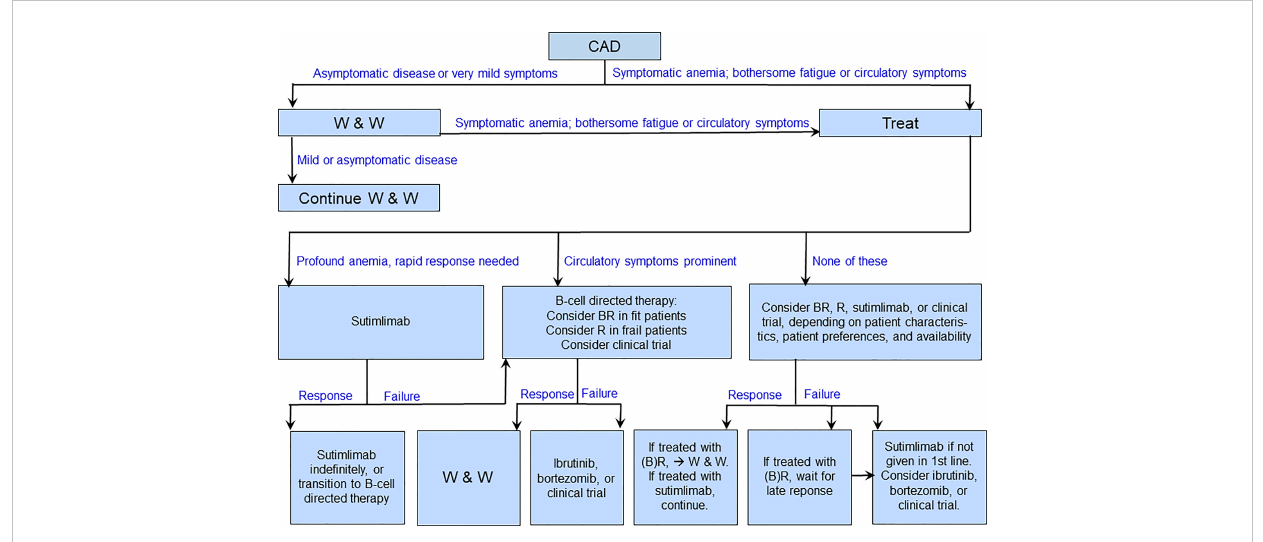
FIGURE 4 Suggested therapeutic algorithm in cold agglutinin disease. B, bendamustine; R, rituximab; W&W, watch and